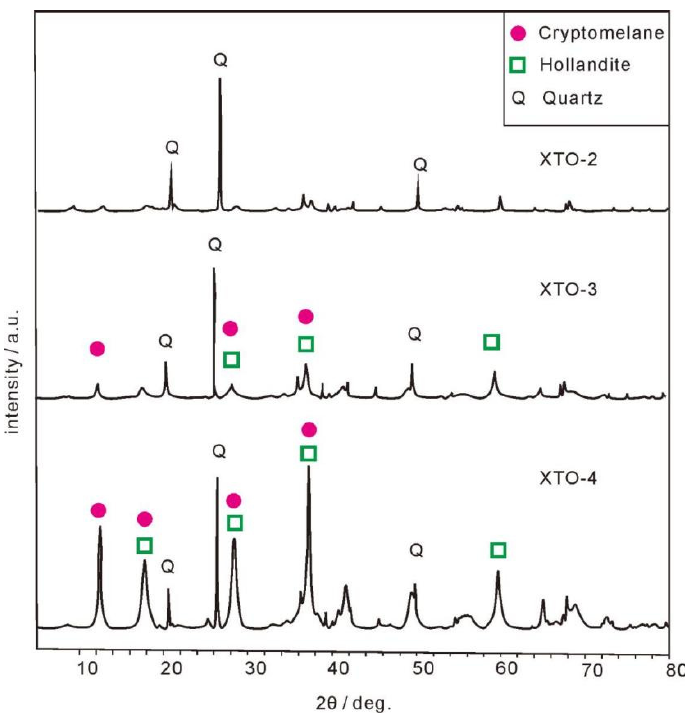
Figure 6. Representative powder diffractograms of the Mn-oxide ore samples from the Xiangtan deposit.